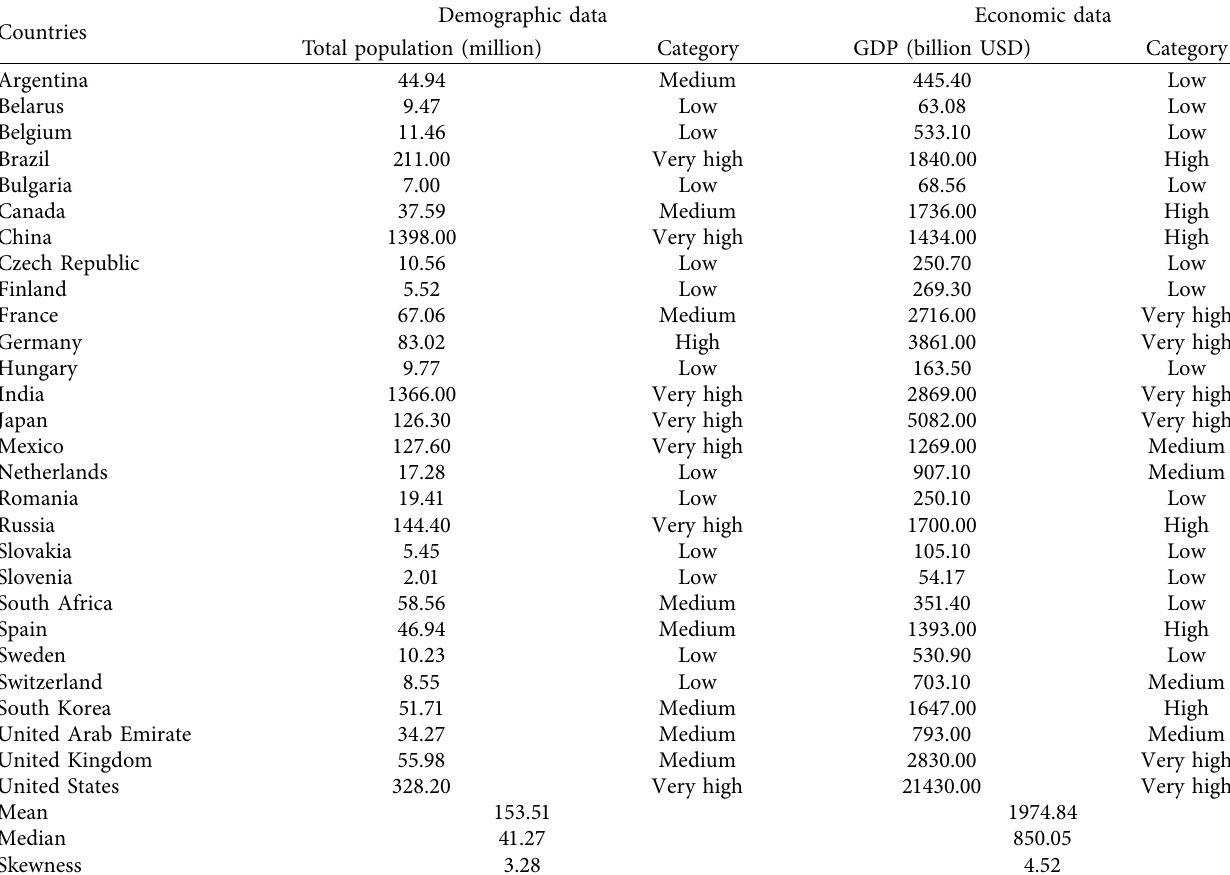
Table 4: Total population and GDP of countries with active